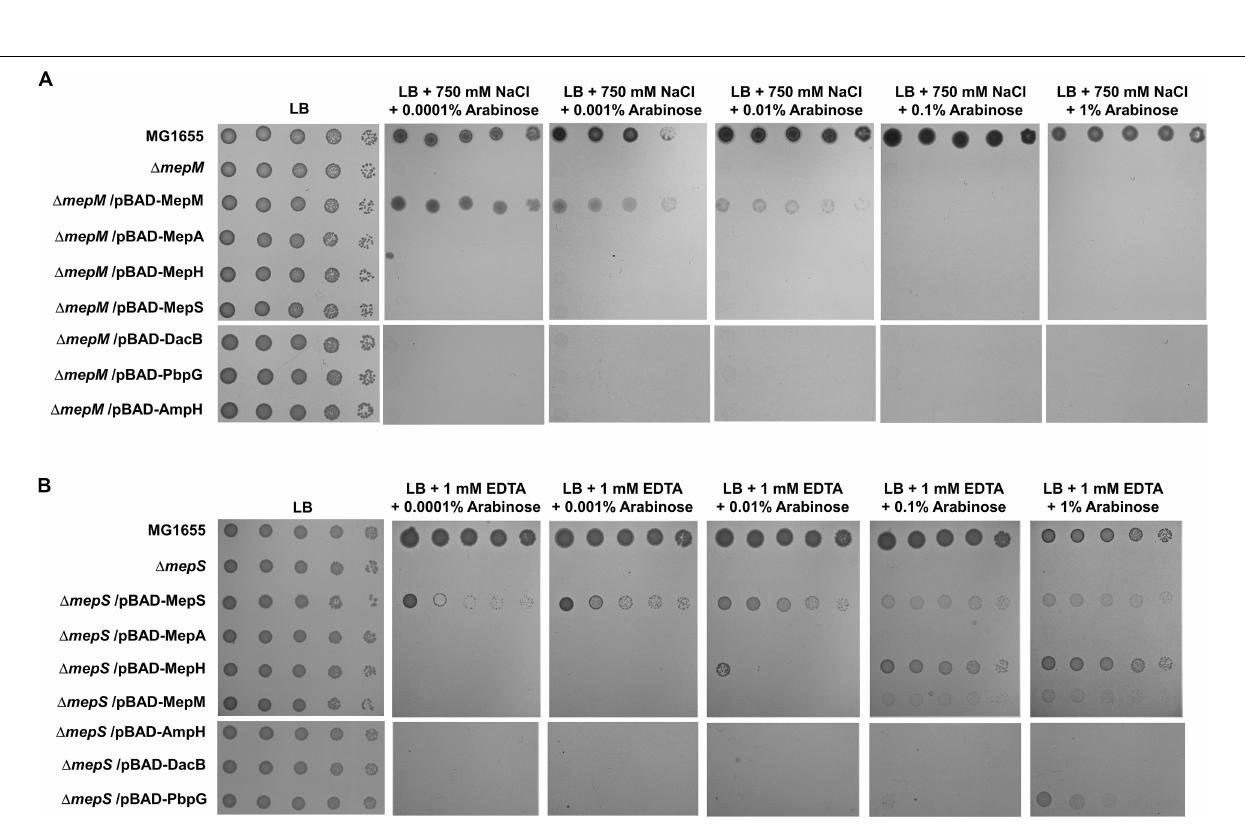
Frontiers in Microbiology |